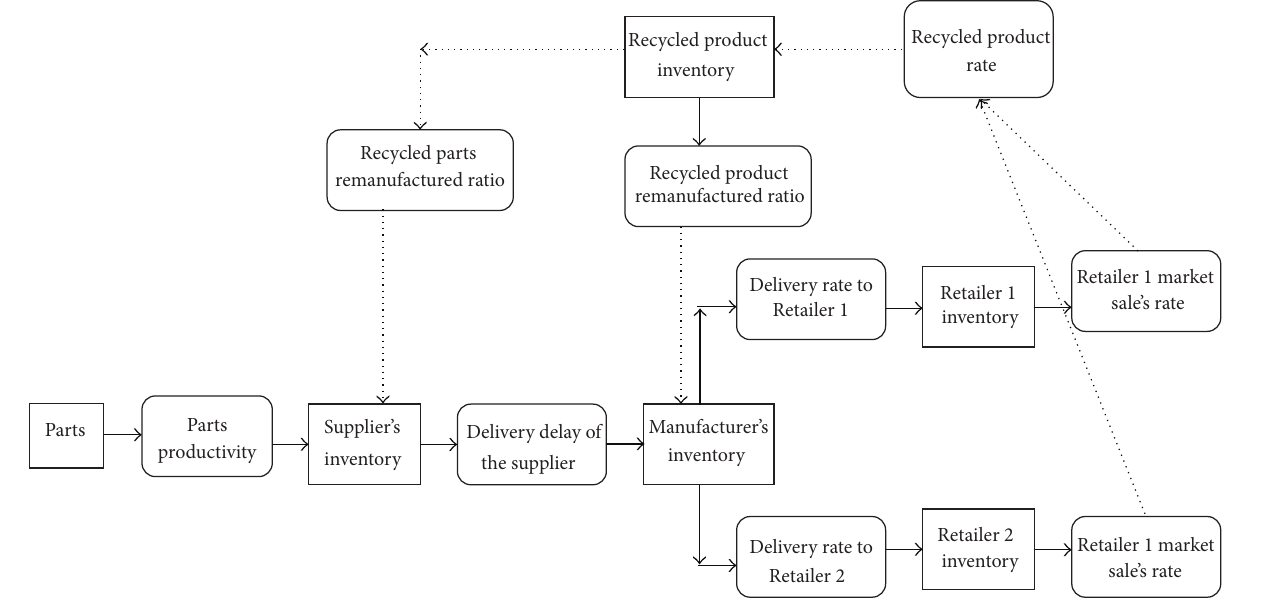
Figure 2: Flow chat of the supply chain distribution system.